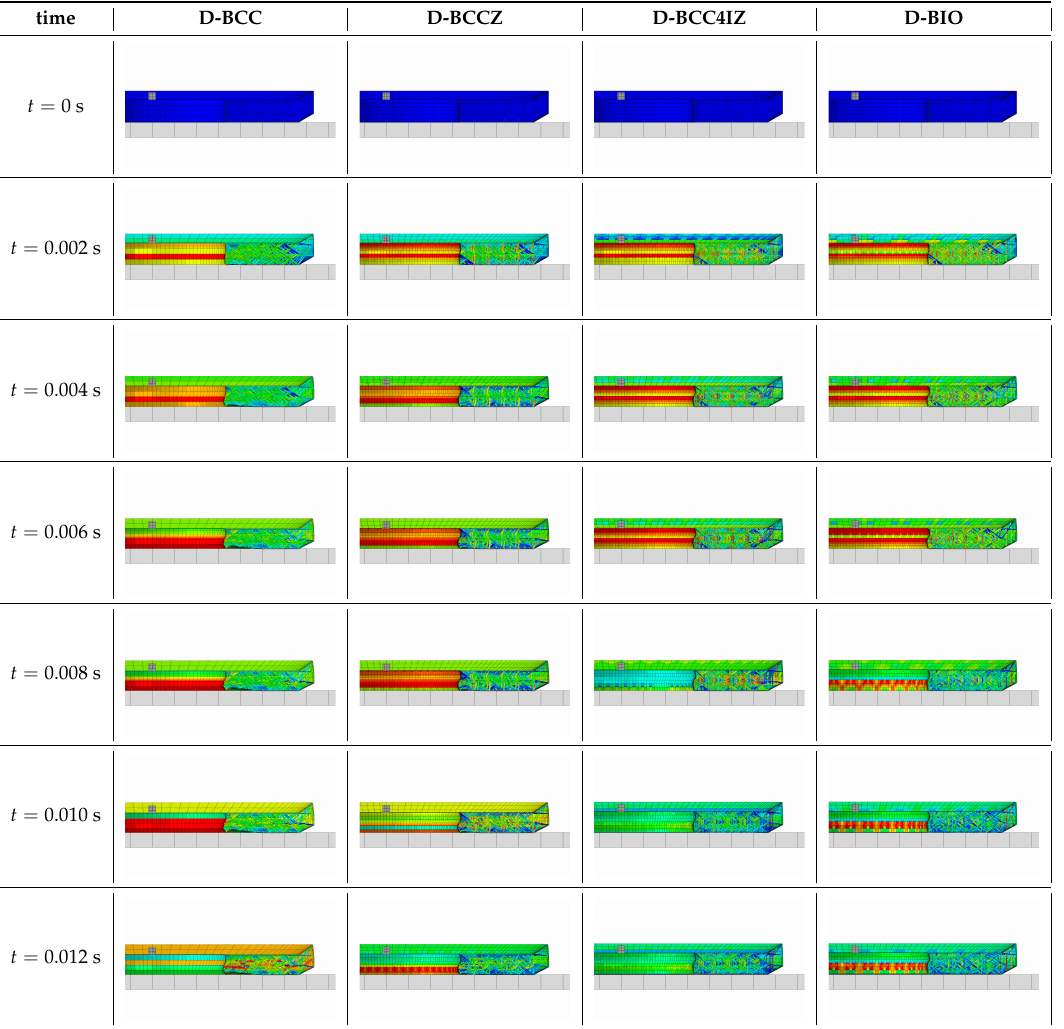
Figure 15. Landing cushioning process magnitude displacement results of the four designs under vertical cushioning